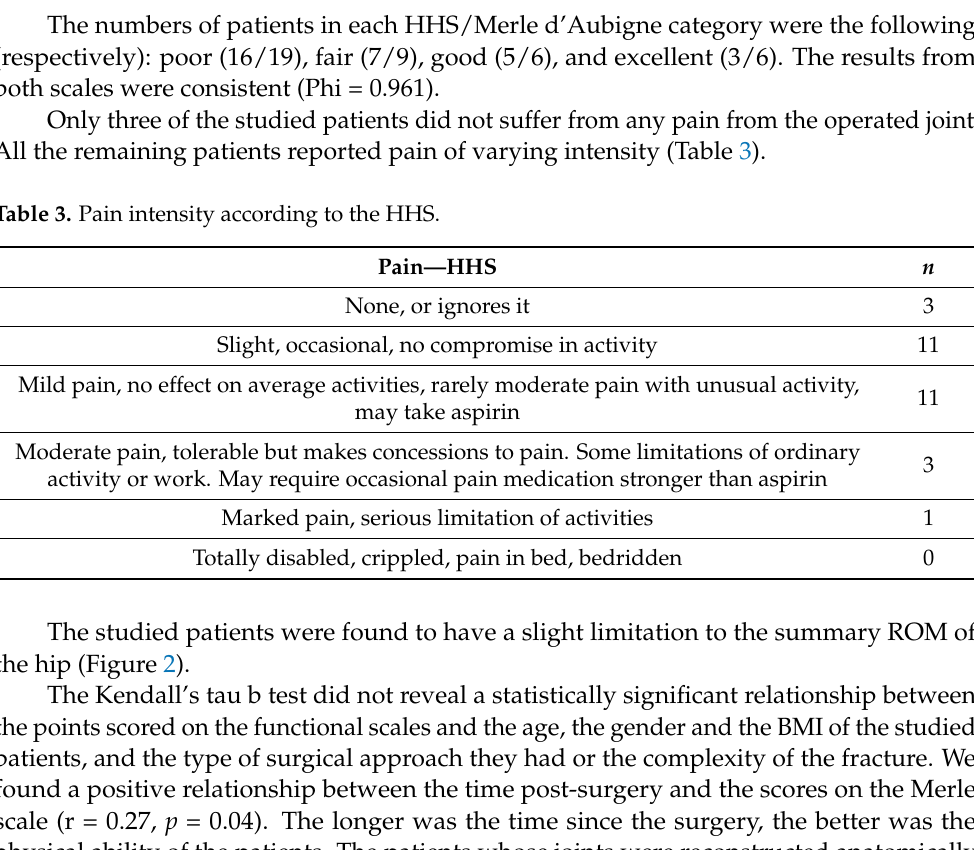
Table 2. Patients’ functional state—norms. Study Population Functional State—Norms [26,27] Scale – X SD Poor Fair Good Excellent HHS [points] 68.9 16.3 <70 70–79 80–89 90–100 Merle [points] 12.0 2.8 <13 13–14 15–17 18